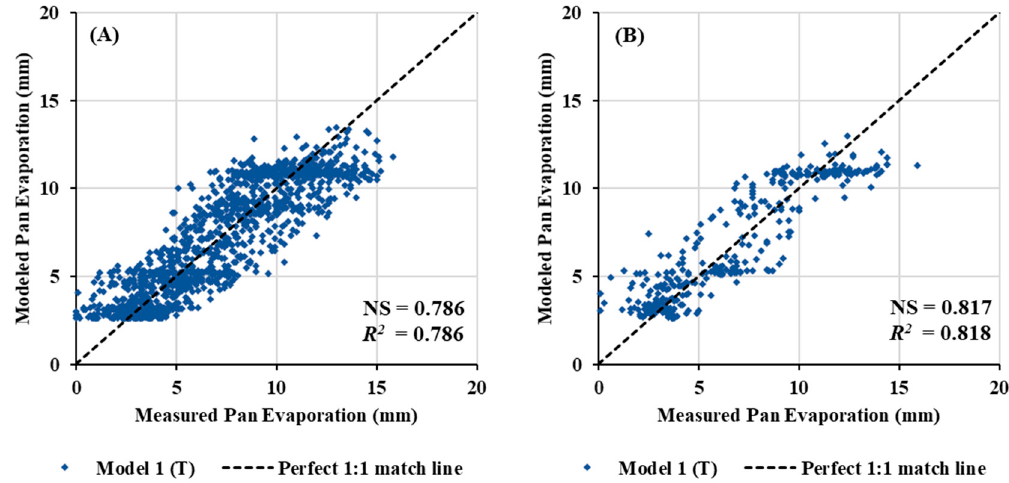
Figure 9. Modeled versus measured pan evaporation data for the Abdaly weather station during the ( A ) training period; ( B ) validation period.